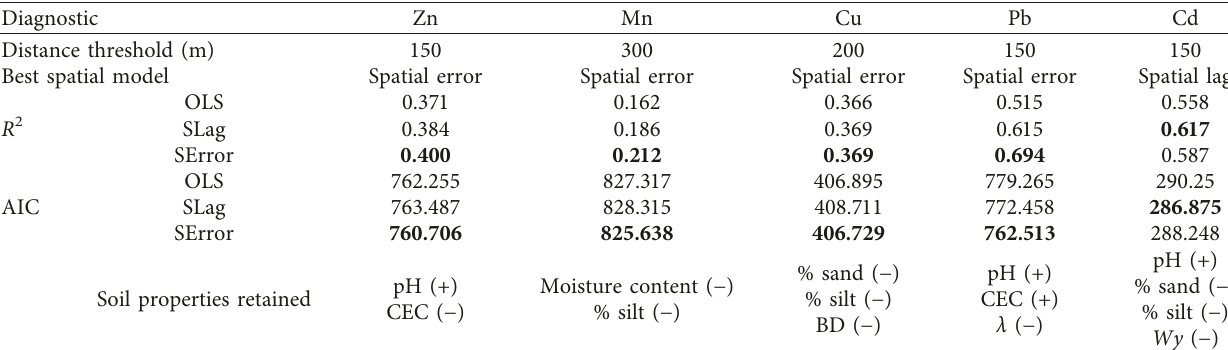
Table 4: Spatial multivariate regression